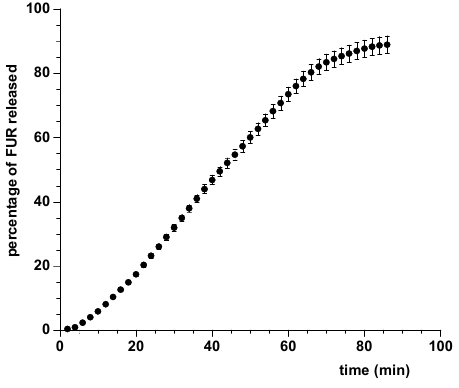
Figure 6. Cumulative percent of FUR released from patch in simulated saliva pH 6.8. Values are presented as means ± SD ( n = 6).